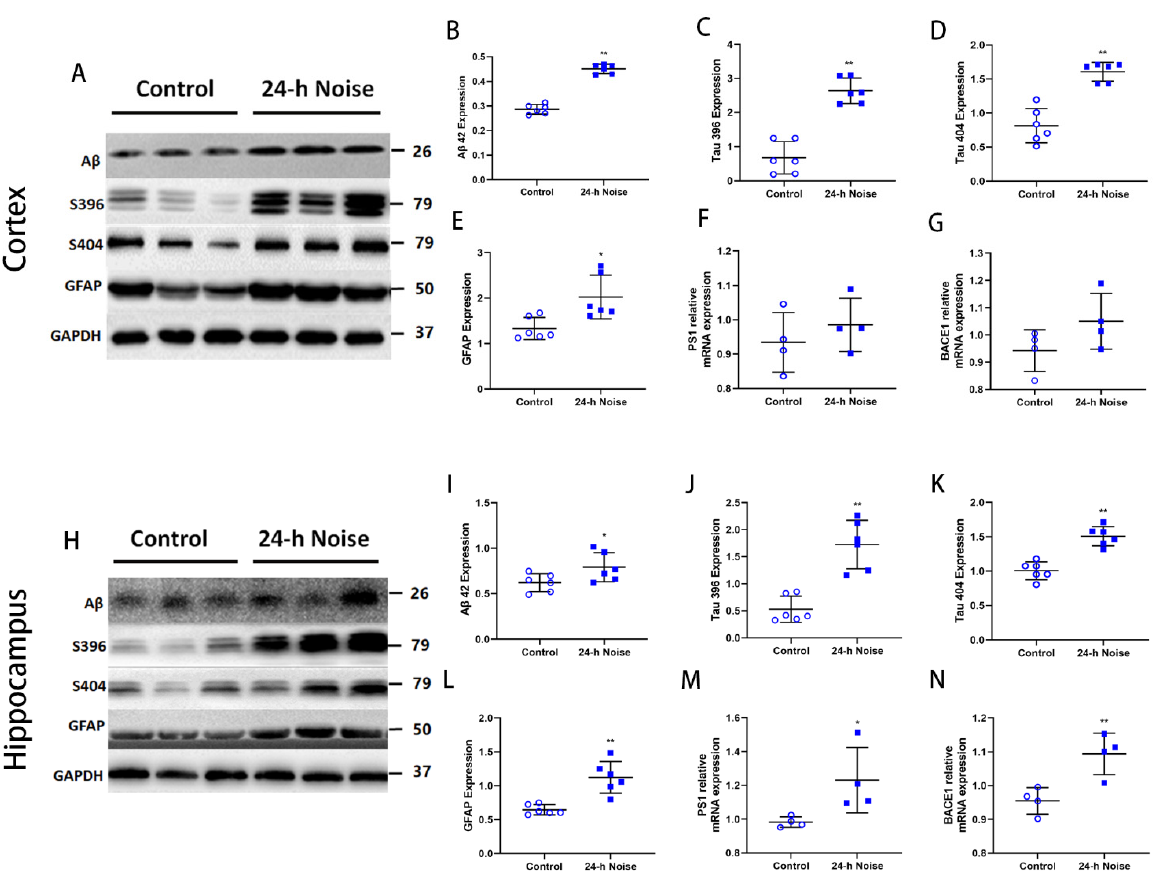
Figure 1. Around-the-clock noise (24 h/day) exposure leads to AD-like neuropathology in the cortex and hippocampus of rats. ( A , H ) Western blot of A β , phosphorylated tau, and GFAP expression in the cortex and hippocampus. ( B – E , I – L ) Quantification data showed that around-the-clock noise (24 h/day) increases the expression of A β , Tau396, Tau404, and GFAP in the cortex and hippocampus ( n = 6 per group). ( F , G , M , N ) The mRNA expression of PS1 and BACE1 in the cortex and hippocampus ( n = 4 per group). * p < 0.05, ** p < 0.01.